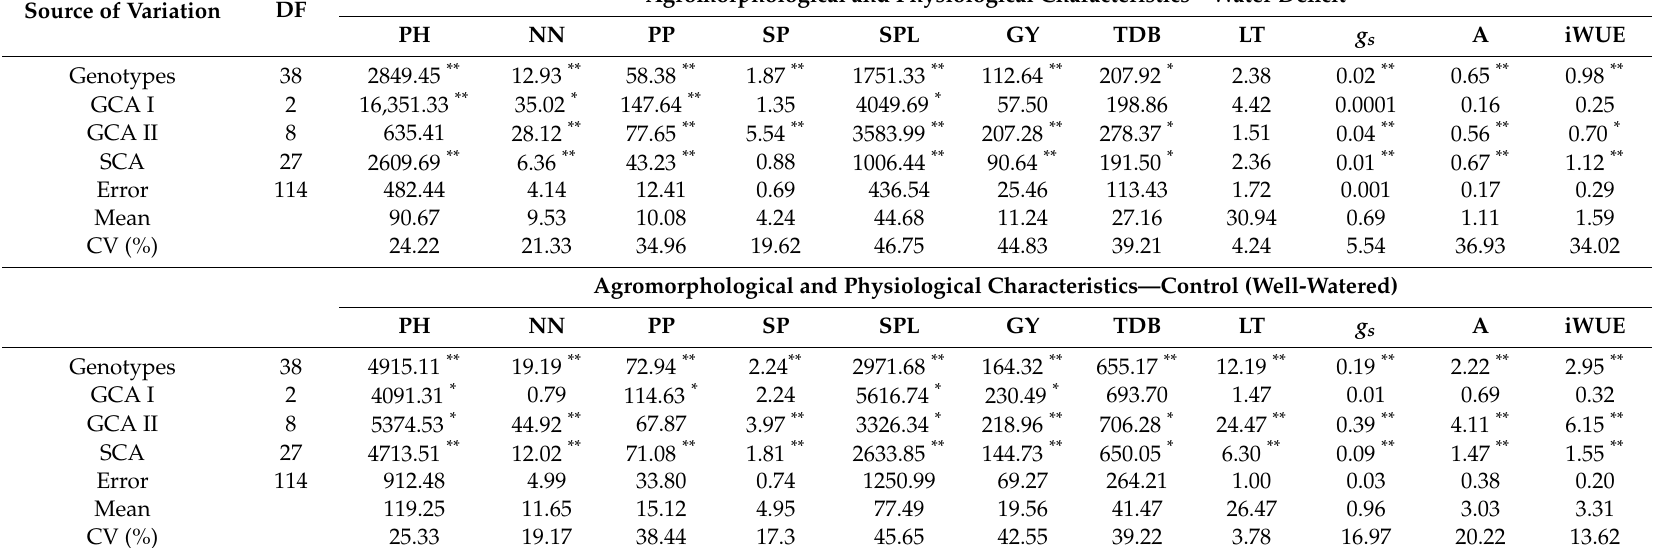
Table 2. Analysis of variance for agromorphological and physiological traits of the common bean genotypes under water deficit and control condition (well-watered). Source of